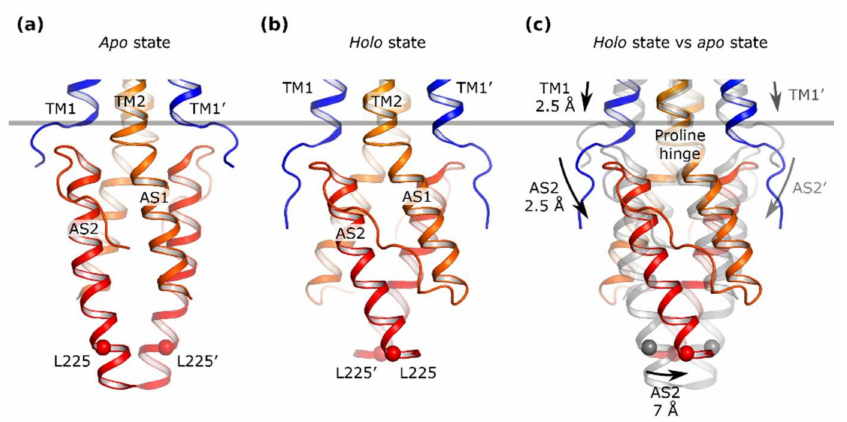
Figure 11. Details of the signal transduction from the TM domain to and through the HAMP domain. ( a ) Ligand-free state. ( b ) Ligand-bound state. ( c ) Superposition of the ligand-free (gray) and ligand- bound (colored) states. A piston-like displacement of the cytoplasmic end of the helix TM1 relative to TM2 and the TM2-AS1 proline hinge is transmitted to the membrane-proximal end of AS2 and results in lever-like rotations of the HAMP domain protomers around the hinges. Since the HAMP domain protomers move in opposite directions, the positions of membrane-distal ends of helices AS2 also change relative to each other. Positions of the Leu225 C α atom are marked with the spheres. The gray bar shows the position of TM1 ends in the apo state structure. The domains are aligned by the residues 175–177. Reproduced with permission from